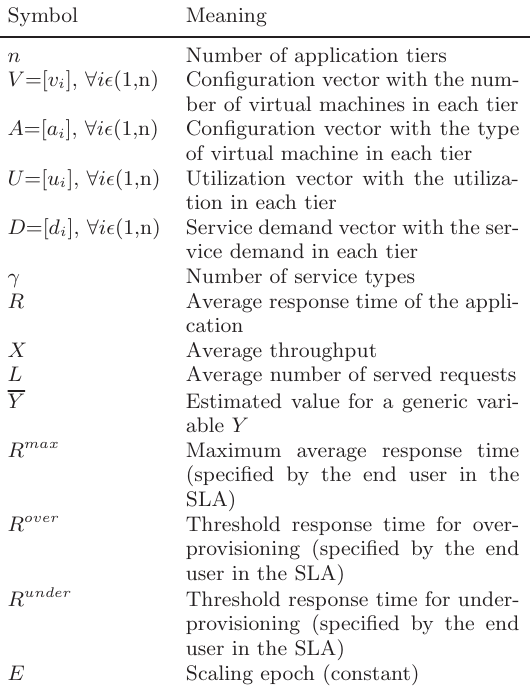
Table 1: Summary of notations